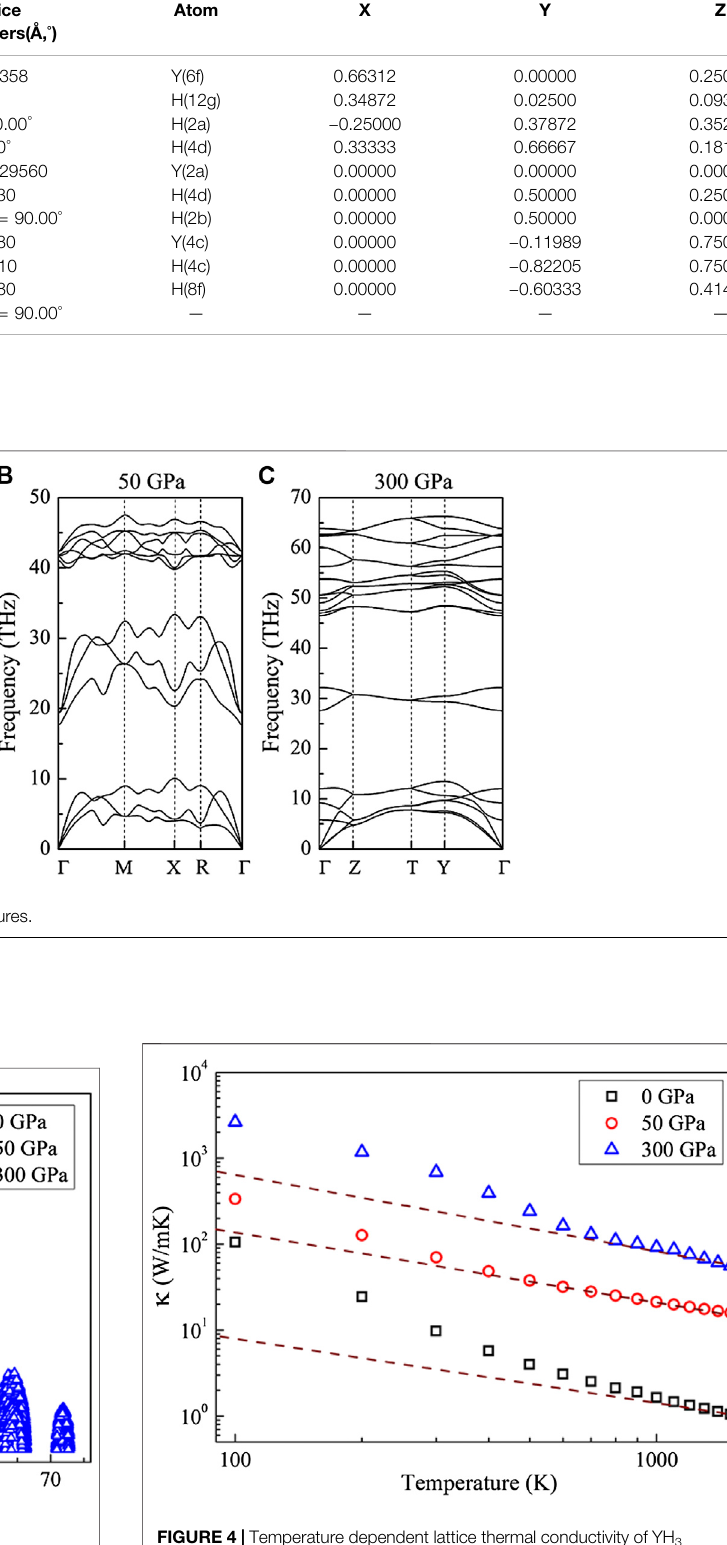
FIGURE 3 | Phonon group velocity for YH 3 under different pressures.